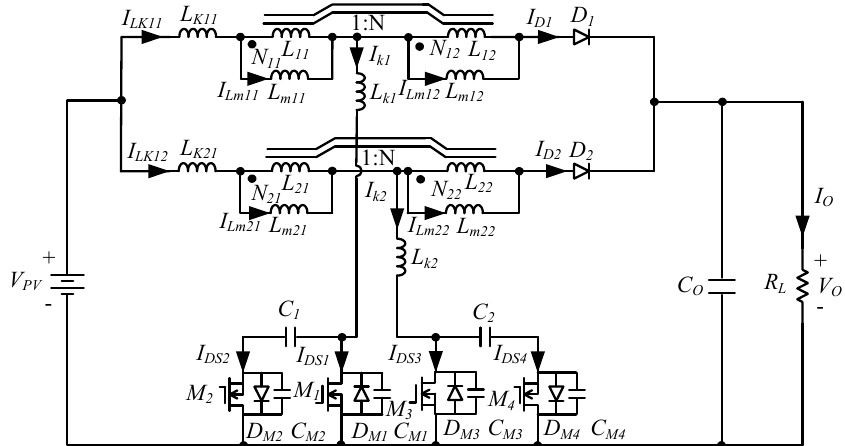
Figure 3. Schematic diagram of interleaved active clamp boost converter with coupled